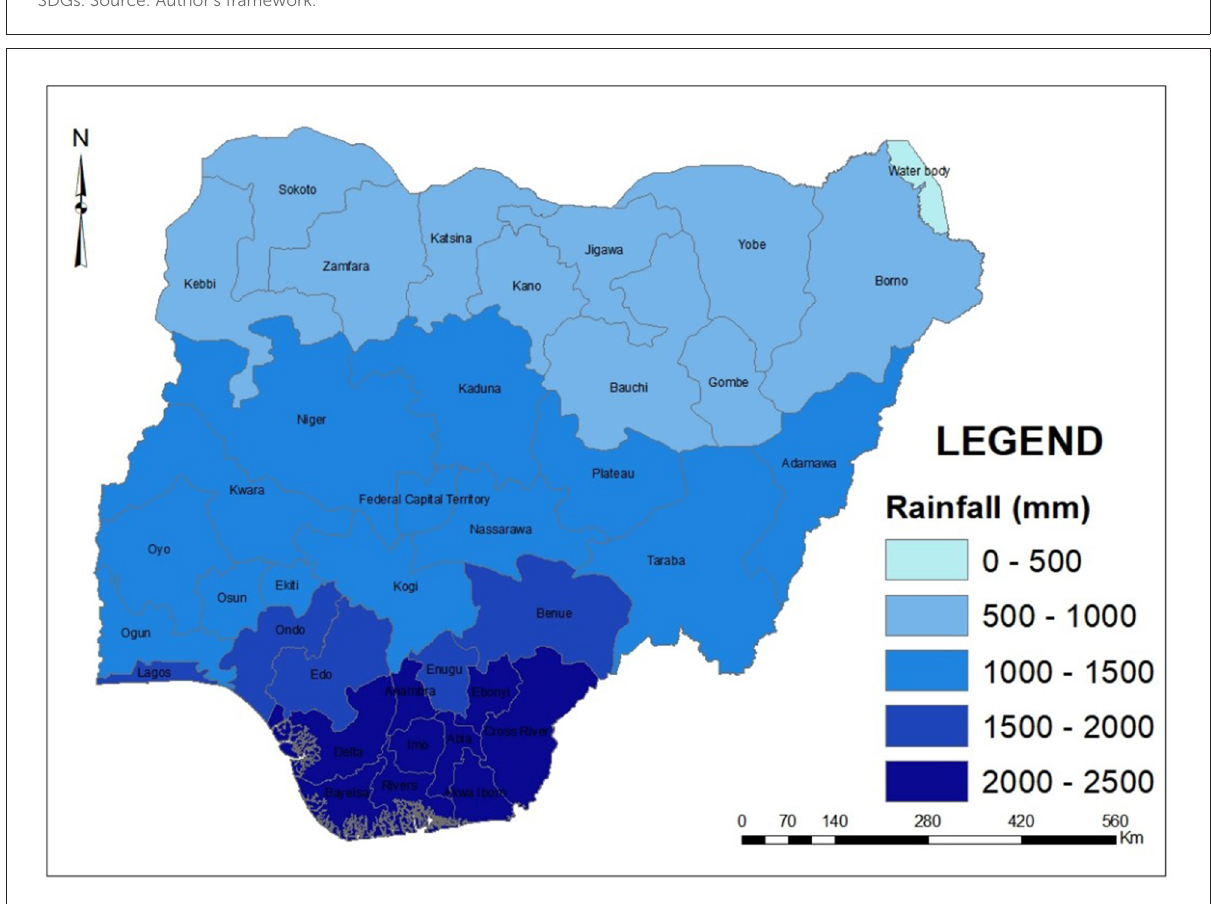
FIGURE1 Conceptual framework depicting interdependencies between the study components. It relates the interconnectivity between the components of food security and several determinants, including climate change, energy use, food costs, and political instability, vis à vis the attainment of SDGs. Source: Author’s